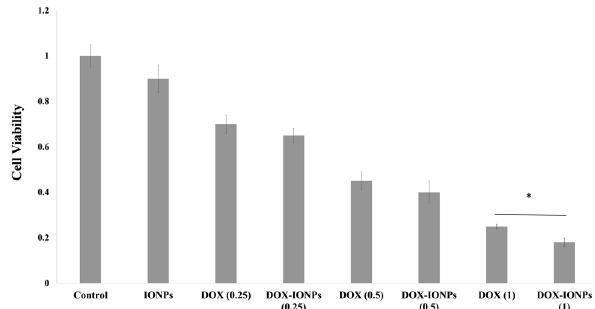
Figure 5. Cytotoxicity assessment of various concentrations of DOX and DOX-EDT-IONPs (0.25, 0.5 and 0.1 µg/mL) on U251 after 48 h treatment. *Indicates a significant difference at p < 0.05. Data is presented as mean ± S.D, and n = 6. The Y-axis represents cell viability compared to the control. IONPs and DOX-IONPs represent for EDT-IONPs and